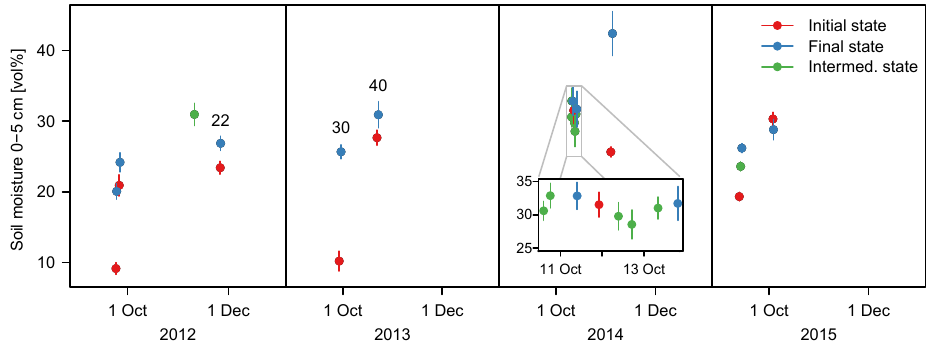
Figure 5. Soil moisture in the topsoil (0–5cm) measured on alert basis before and after major rain events in autumn seasons in 2012–2015. The points show catchment mean values, the lines the range of the mean ± SEM inter cat . . The numbers above selected events give the event number as in Tables 3 and 4 and as referred to in the